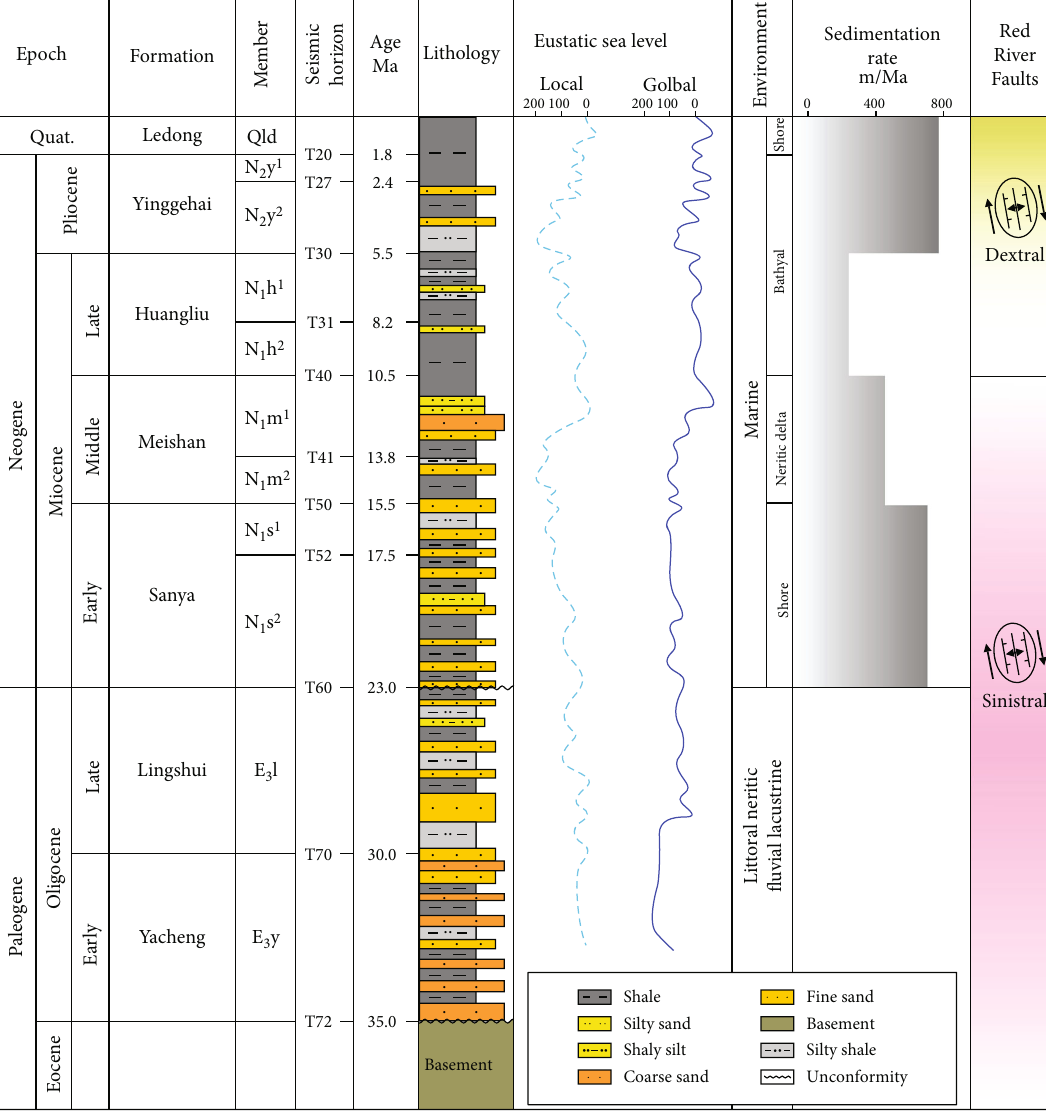
Figure 2: The generalized stratigraphic section of the Yinggehai Basin, showing the formations and symbols, seismic horizons, main lithology, and sedimentary environment (modi fi ed from